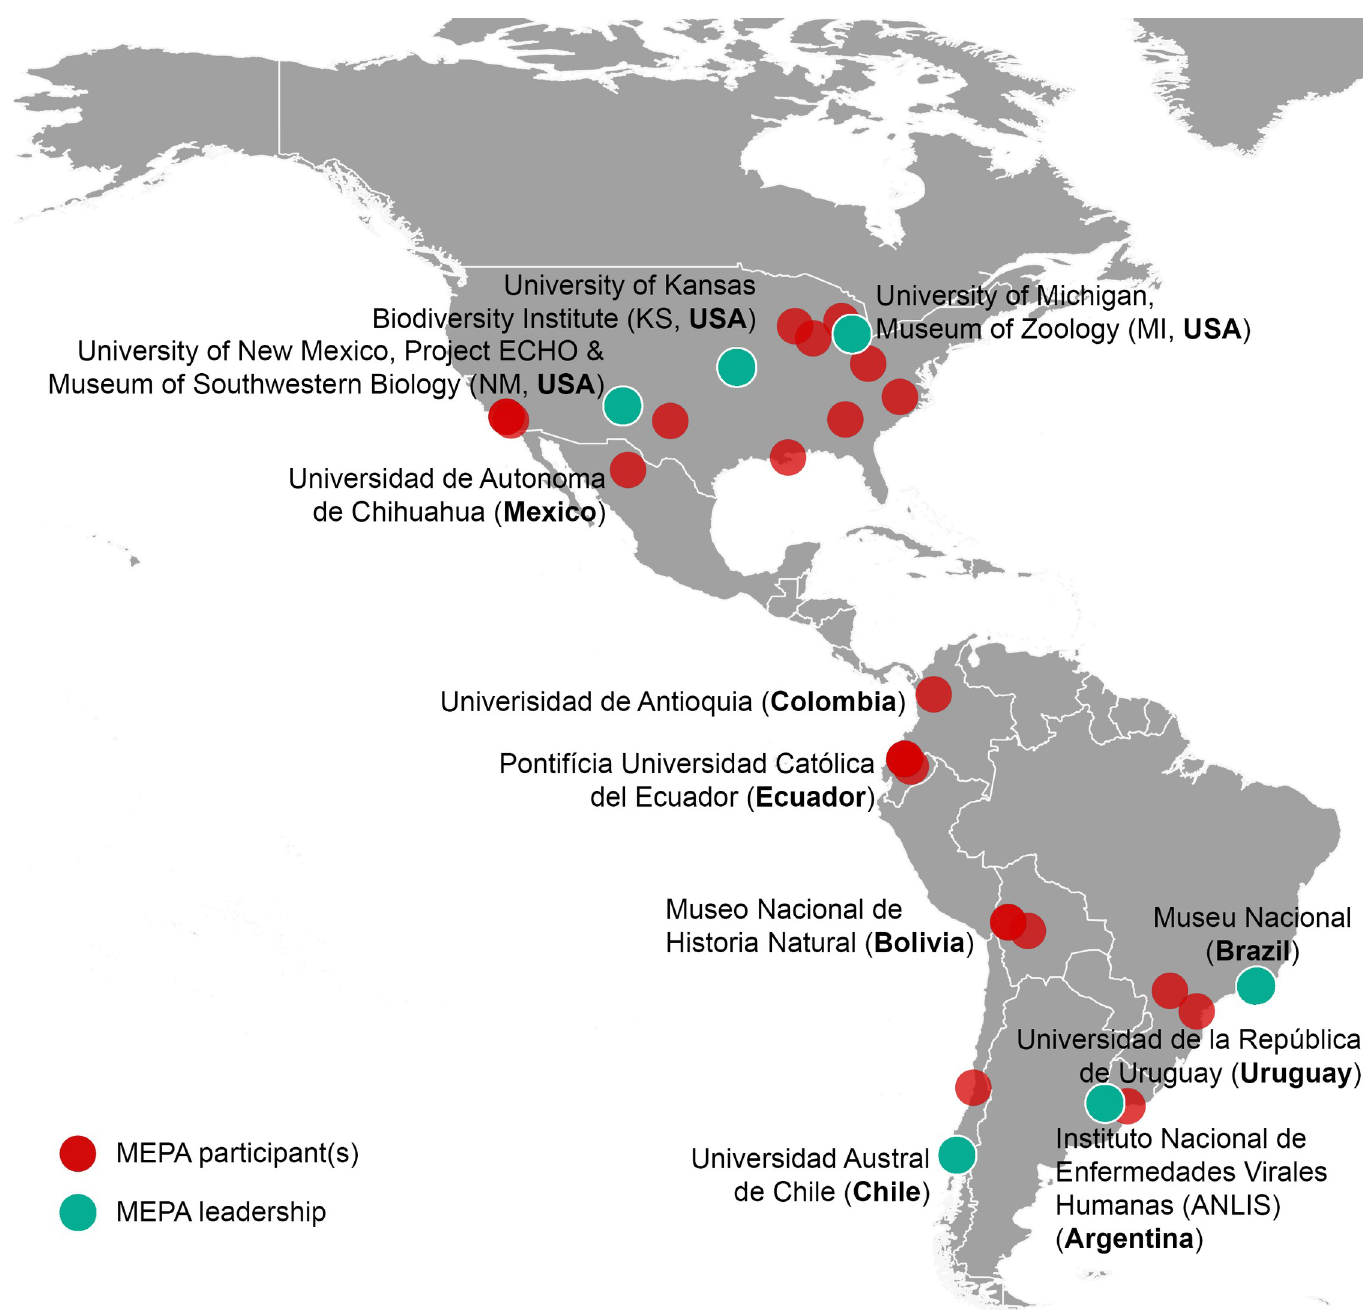
Fig 2. Distribution of institutions participating in MEPA as of February 2021. At least 1 participating institution is labeled per country (plus all leadership institutions). Continent base layer from Natural Earth, available online at https://www.naturalearthdata.com/downloads/10m-cultural-vectors/10m-admin-0-countries/. MEPA, Museums and Emerging Pathogens in the